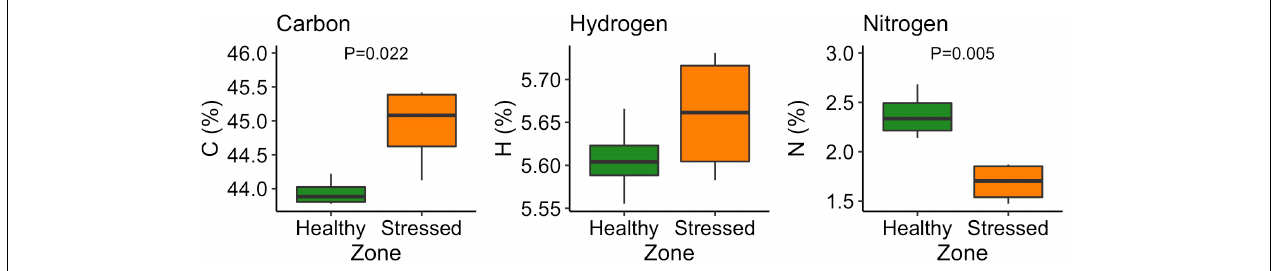
FIGURE 11 | Carbon, hydrogen and nitrogen content of Avicennia marina leaves under “stressed” and “healthy” conditions at the St Kilda mangrove forest, South Australia. The analyses were done on the second youngest leaves. Four leaves were sampled from each of seven plants per zone. P -values are only shown for significant